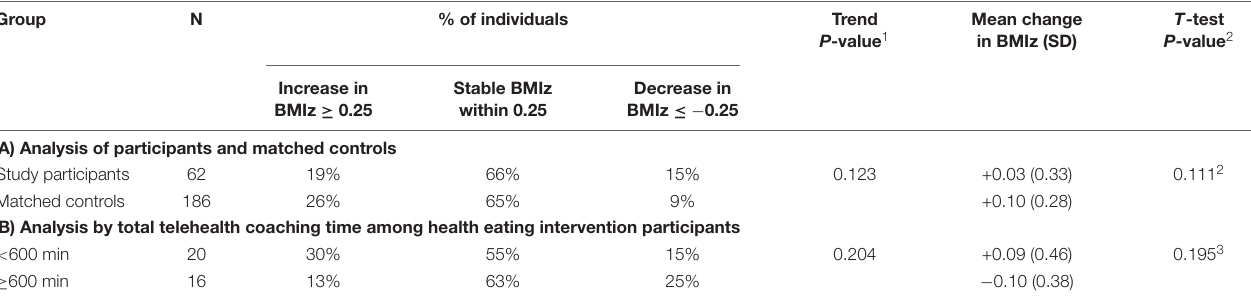
TABLE 3 | Change in body mass index z -score from baseline to 1-year post-intervention follow-up, comparing (A) study participants with matched controls, and (B) healthy eating intervention participants dichotomized by total telehealth coaching time. Group N % of individuals Trend